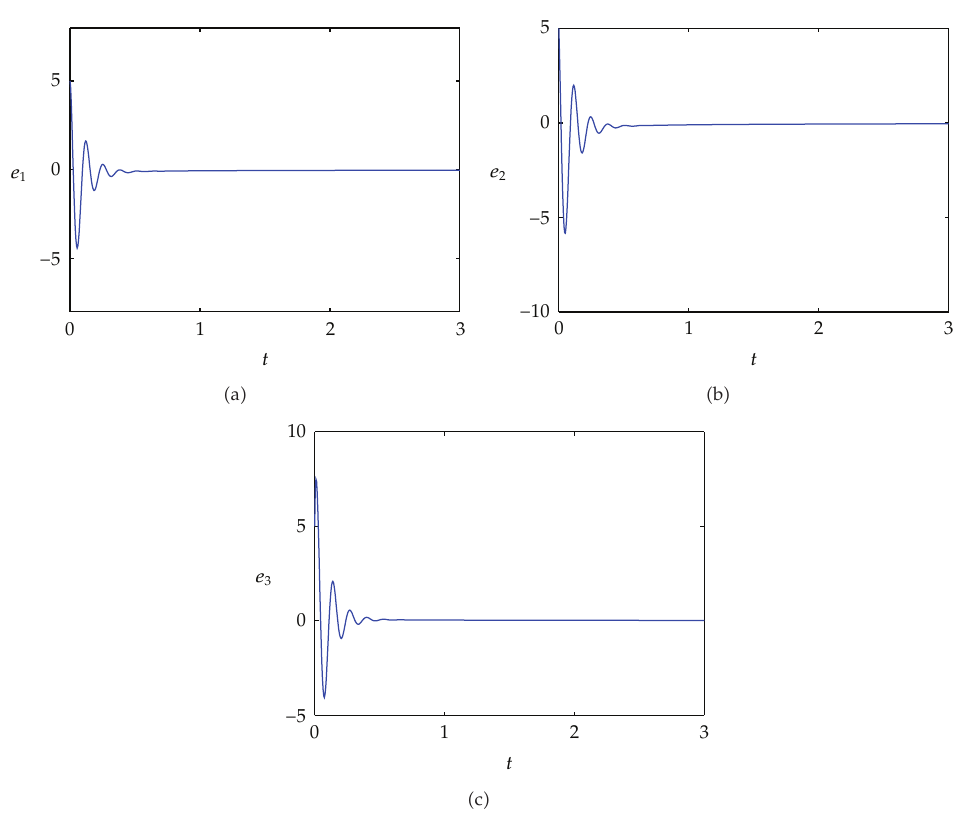
Figure 1: The control simulation result for (cid:6) 10, 9, 15 (cid:7) when q (cid:5) 0 .